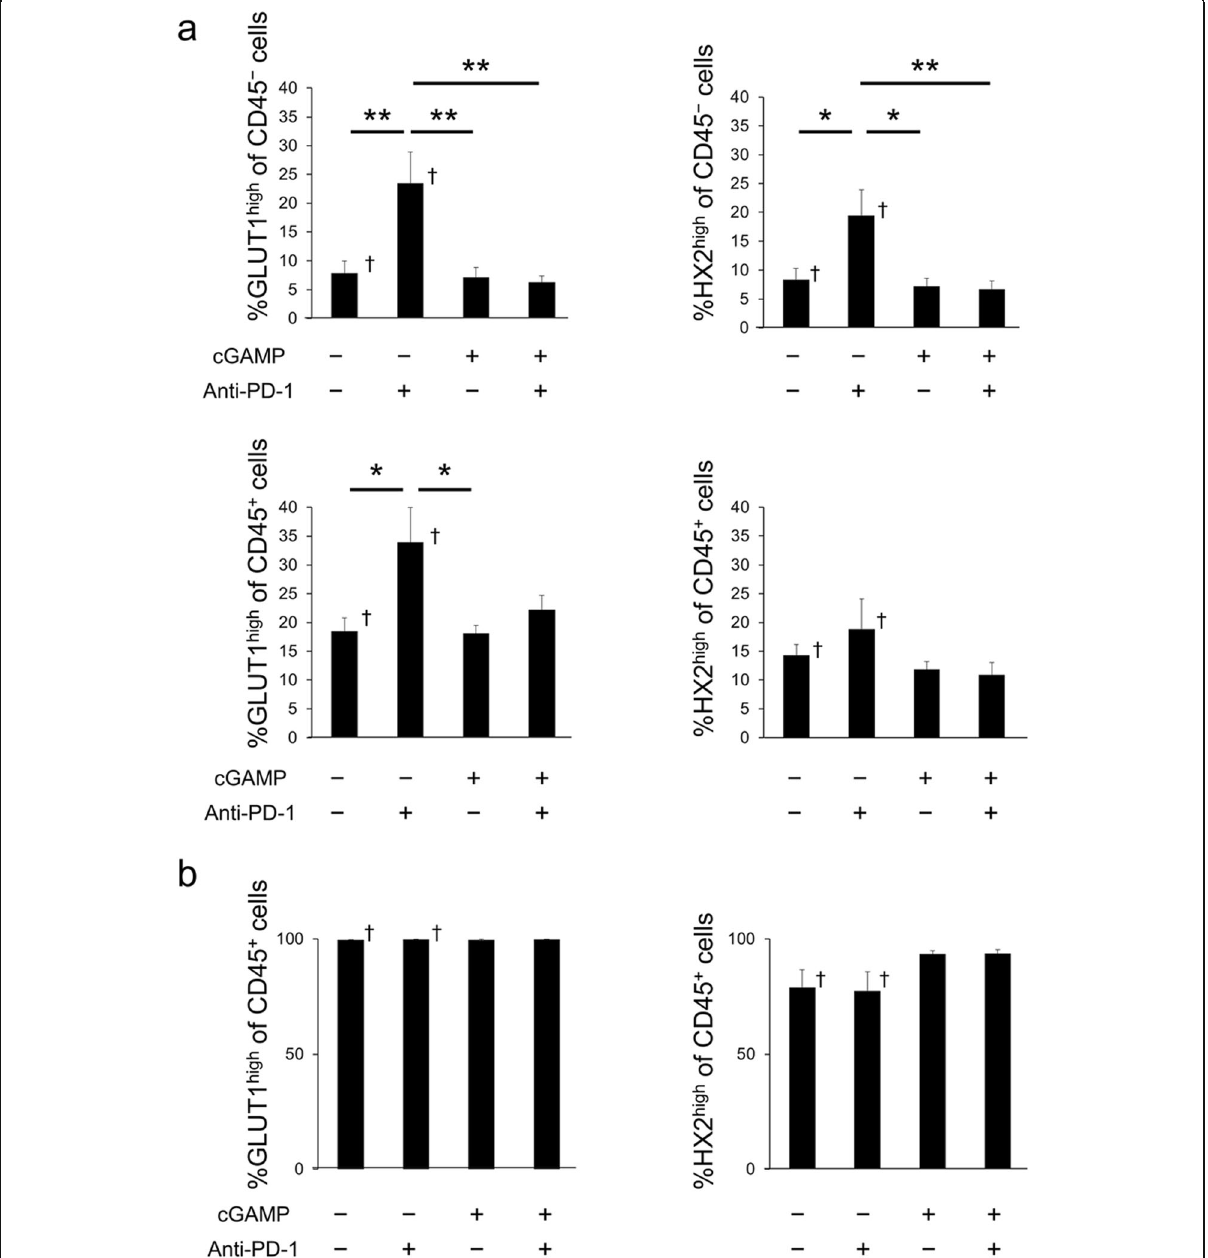
Fig. 5 Flow-cytometry analysis of glycolysis in the cGAMP-injected B16F10 model. a Percentage of GLUT1 (left) and HX2 (right) high expressing cells in CD45 − cancer cells (top) or CD45 + immune cells (bottom) in tumors on day 7 ( n = 5 – 7). Data of the non-treatment group and anti-PD-1- treated group were quoted from [11]. b Percentage of GLUT1 (left) and HX2 (right) high expressing cells in CD45 + immune cells in spleens on day 7 ( n = 5 – 7). Data of the non-treatment group and anti-PD-1-treated group were quoted from [11]. Data represent the mean ± SEM; * p < 0.05; ** p < 0.01; † Adapted from